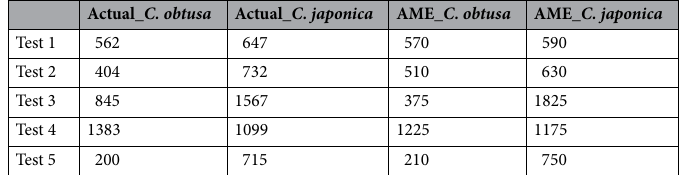
Table 1. Actual and estimated numbers of pollen grains.